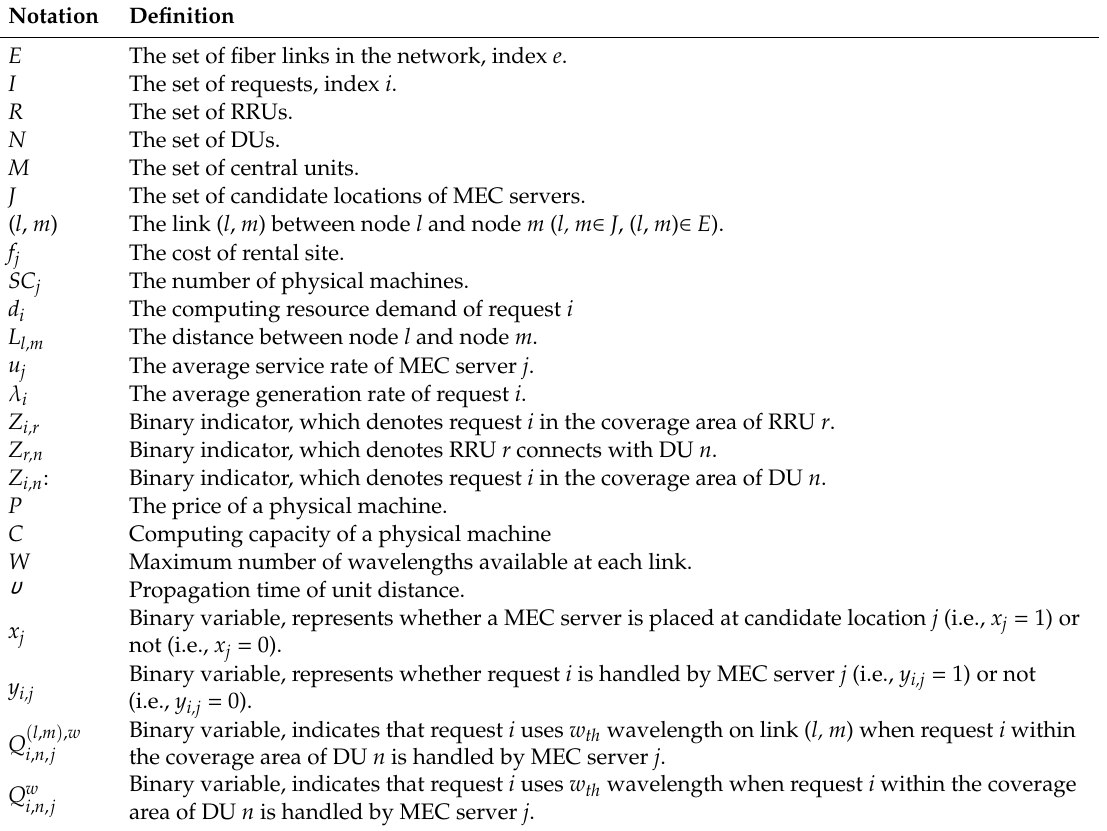
Table 1. Summary of Notations.